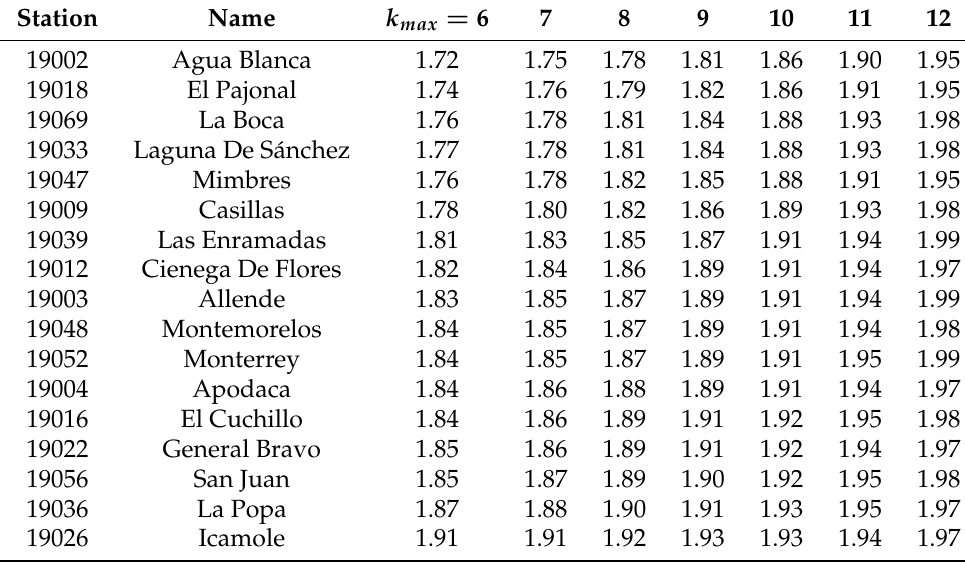
Table A1. Results of HFD for the 17 stations analyzed with different k max . Stations are shown in an ascendant order according to k max =